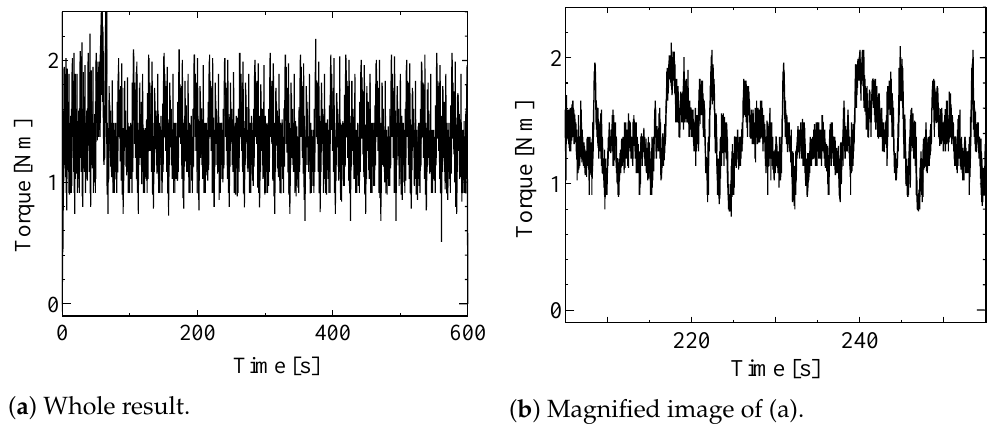
Figure 17. Ten minutes of continuous